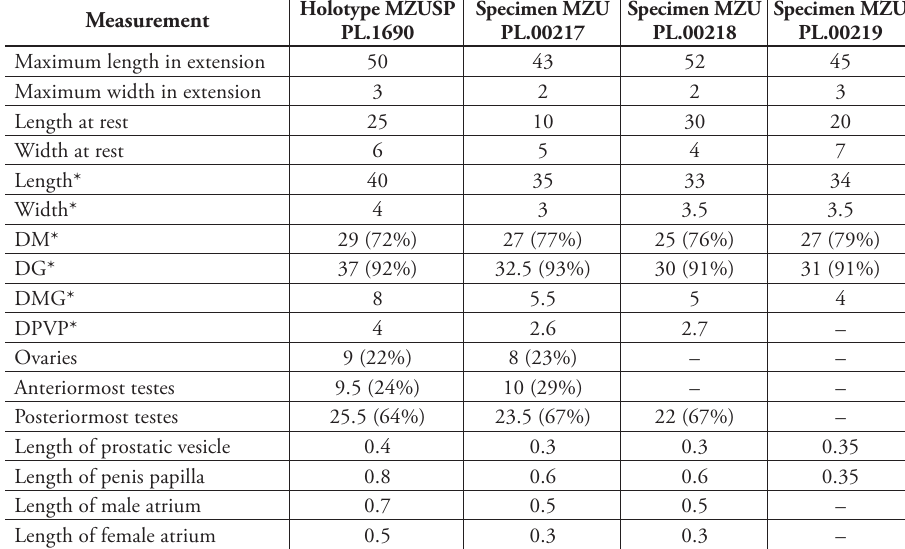
Table 1. Measurements, in mm, of specimens of Cratera cryptolineata sp. n. Abbreviations: – not meas- ured; * after fixation; DG distance of gonopore from anterior end; DM distance of mouth from anterior end; DMG distance between mouth and gonopore; DPVP distance between prostatic vesicle and pharyn- geal pouch. The numbers given in parentheses represent the position relative to body length.